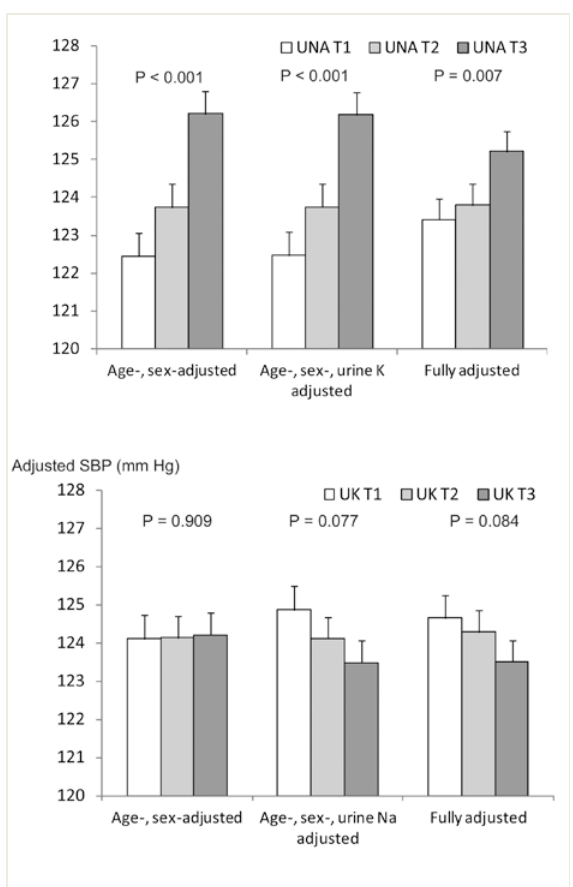
Table 3: Multivariable logistic regression for hypertension (n = 1336).